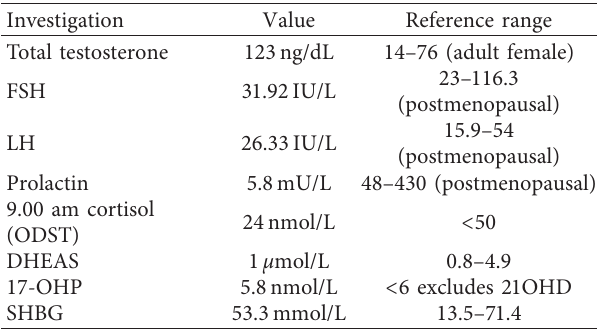
Table 1: Relevant hormonal evaluation of the